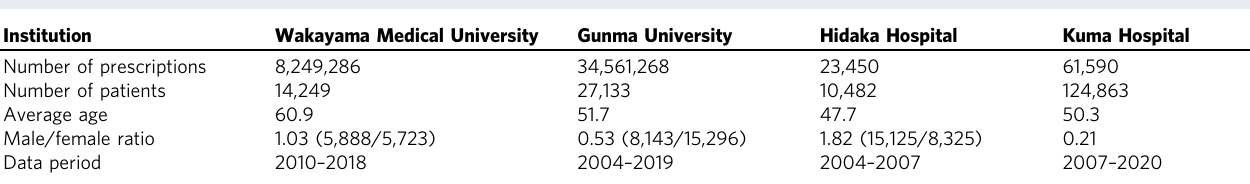
Table 1 Summary of the data from each